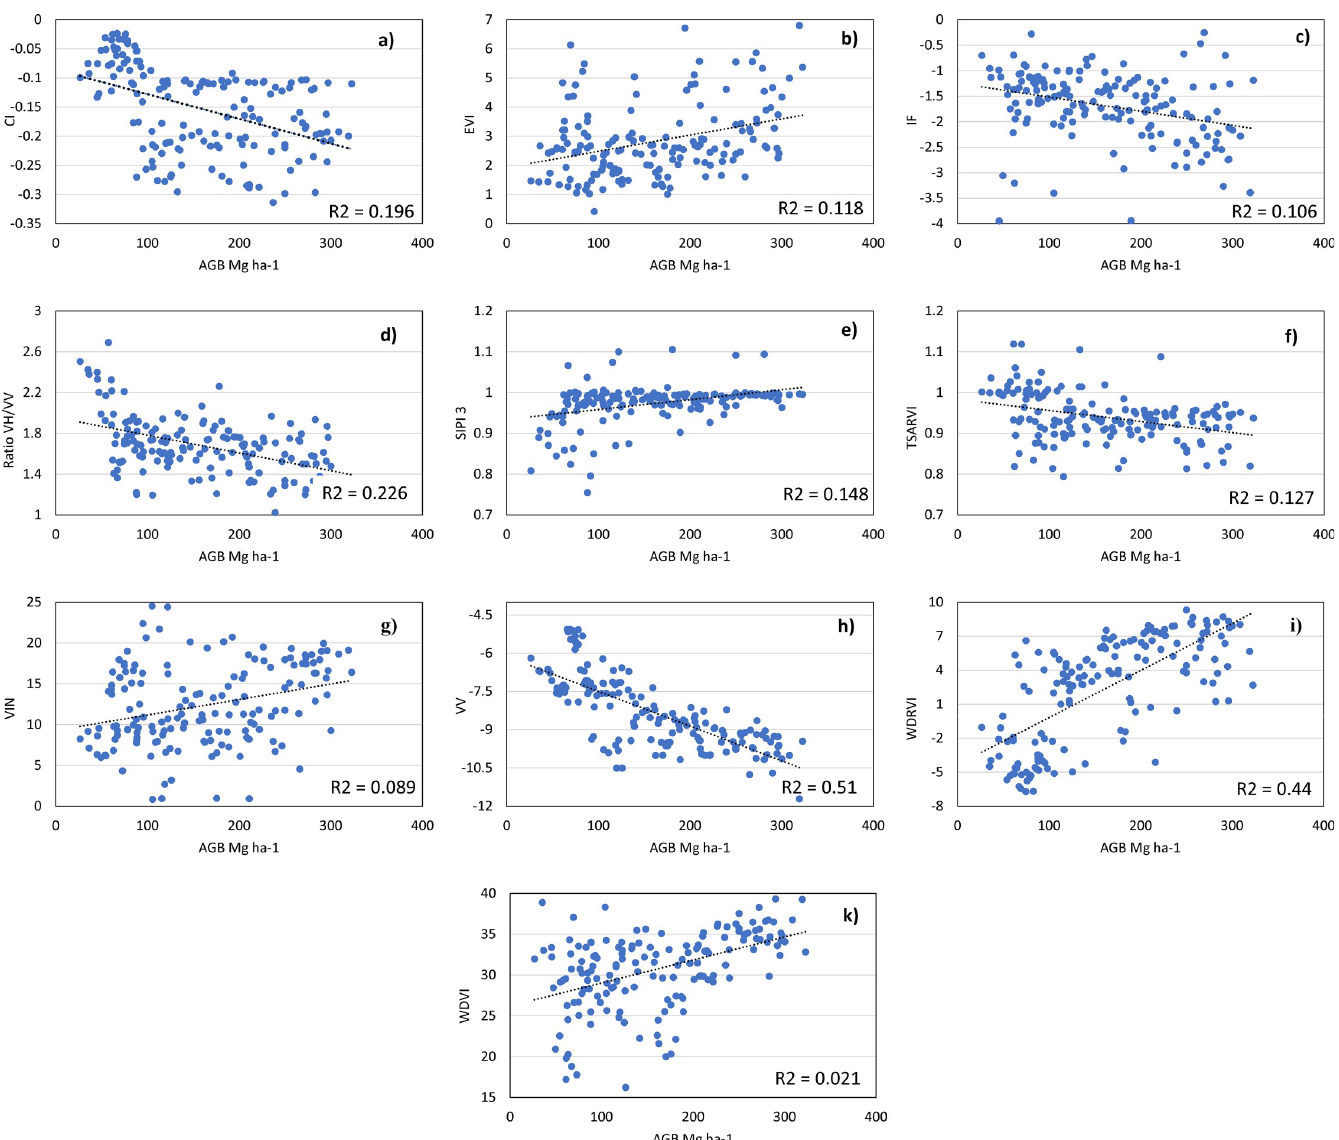
Fig 5. Scatter plots of 10 selected features by GA against the AGB of the sample plots: a) CI, b) EVI, c) IF, d) VH/VV ratio, e) SIPI3, f) TSARVI, g) VIN, h) VV, i) WDRVI, and k) WDVI.